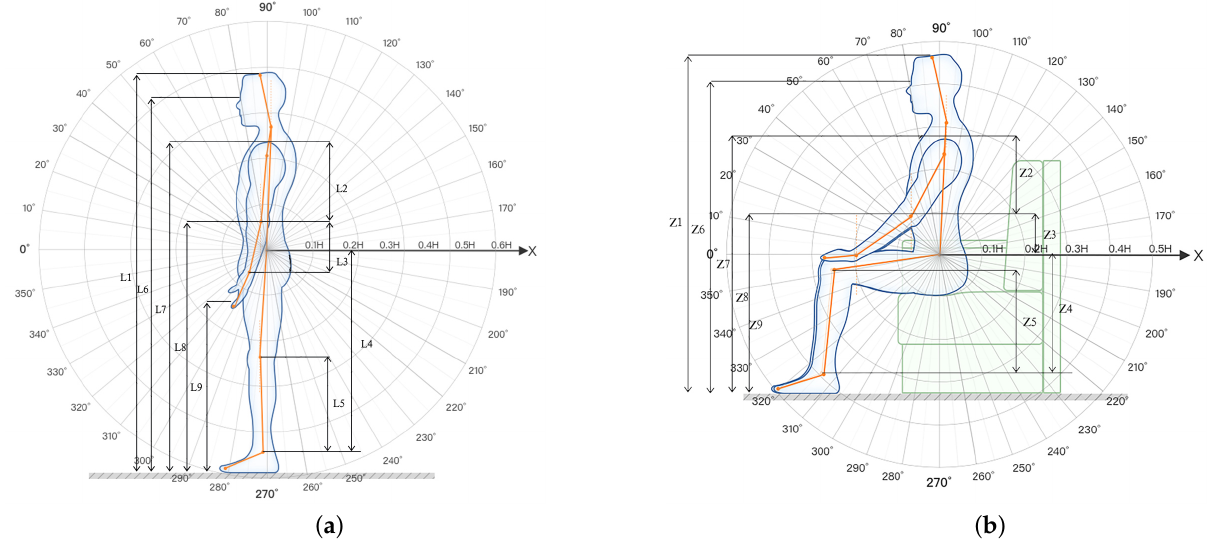
Figure 4. Detailed explanation of the ‘side volume’ of the human body. ( a ) Standing posture measurement area. ( b ) Sitting posture measurement